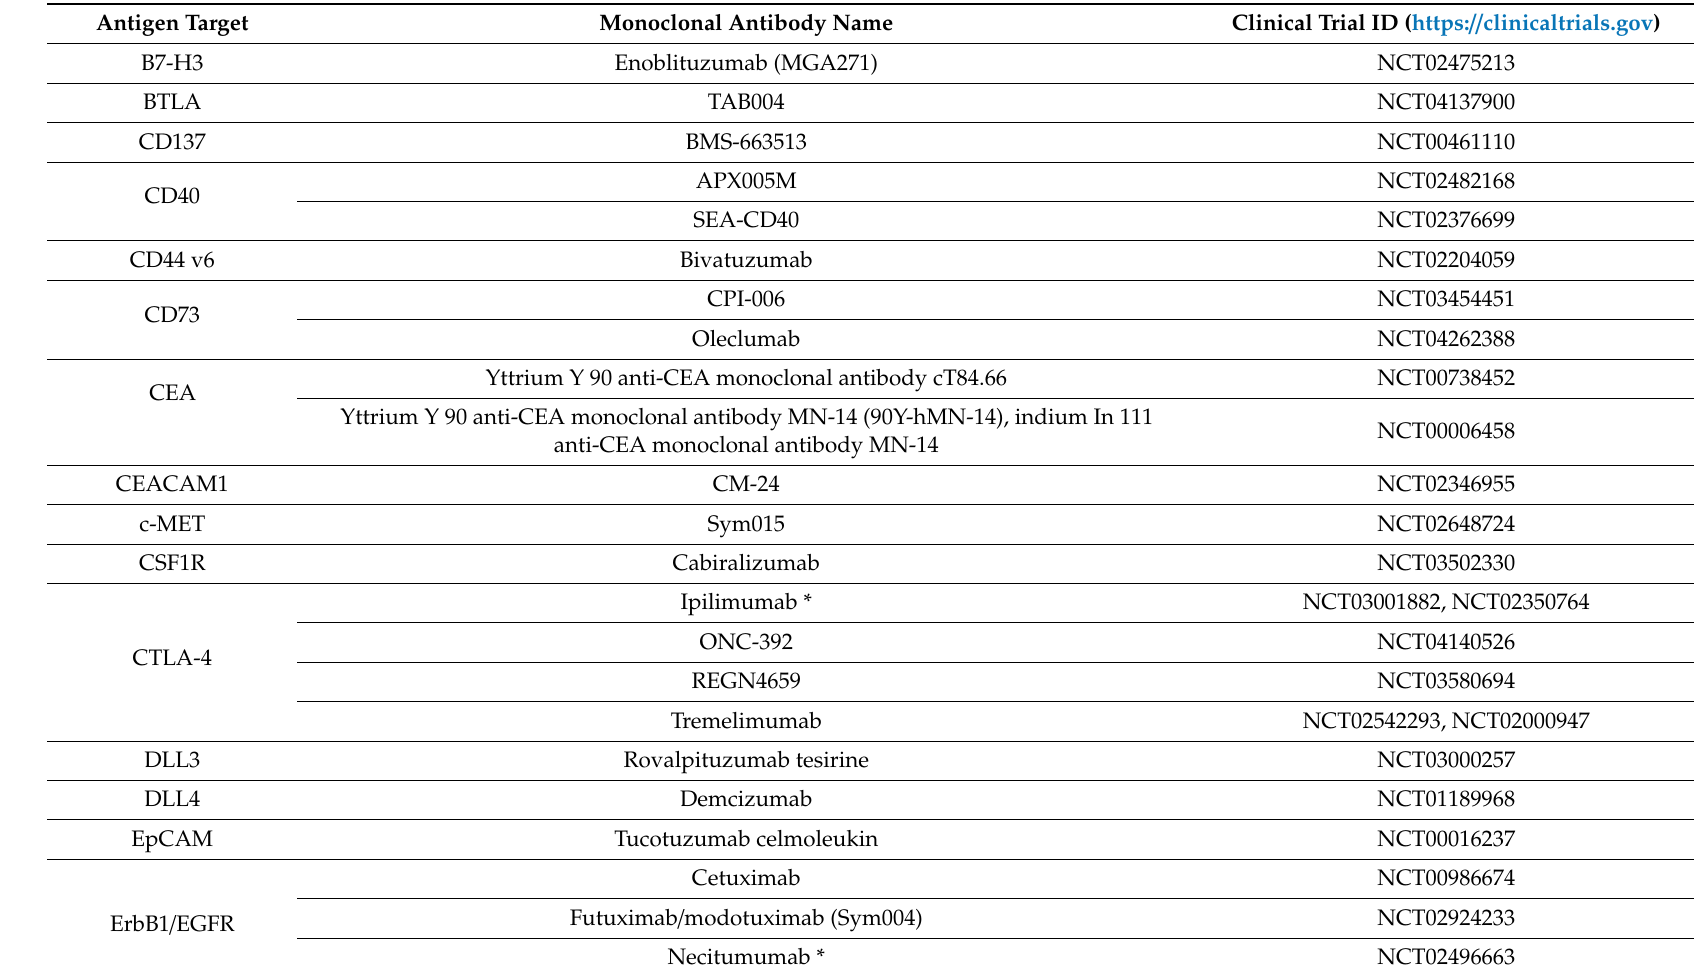
Table 1. NSCLC tumor-associated antigens targeted by monoclonal antibodies that are currently being tested in clinical